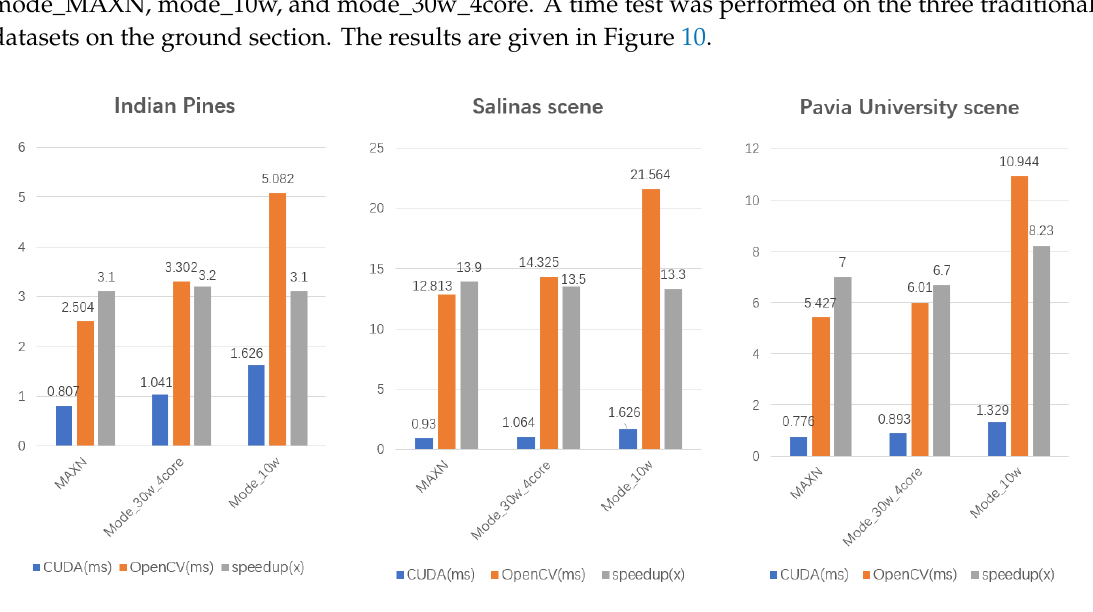
Table 8. Seven working modes of NVIDIA Jetson Xavier.